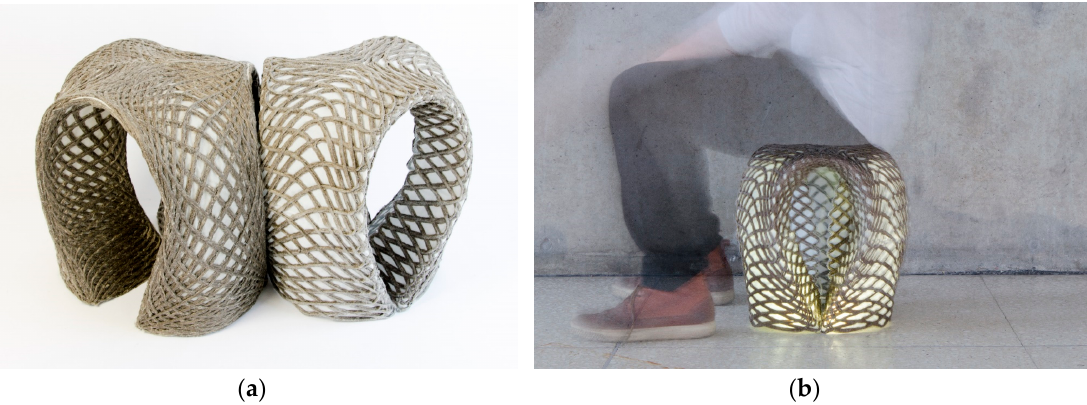
Figure 17. Possible connection of two components ( a ), prototype in use with integrated lighting ( b ).